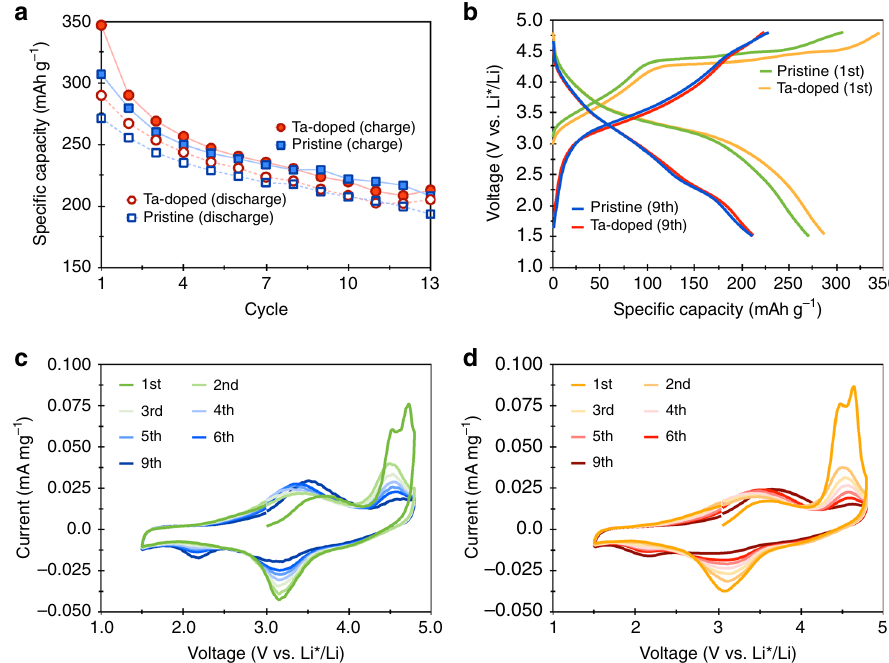
Fig. 6 Cycling performance of pristine and Ta-doped LNMO. The speci fi c capacity of Ta-doped and pristine LNMO over the fi rst 13 cycles ( a ). The Ta- doped samples exhibit higher initial speci fi c capacity compared to the pristine samples. The fi rst and ninth full charge and discharge curves of undoped (green and blue lines) and Ta-doped (yellow and red lines) LNMO ( b ). The cyclic voltammograms of the fi rst 9 cycles for the pristine LNMO ( c ) and Ta- doped LNMO ( d